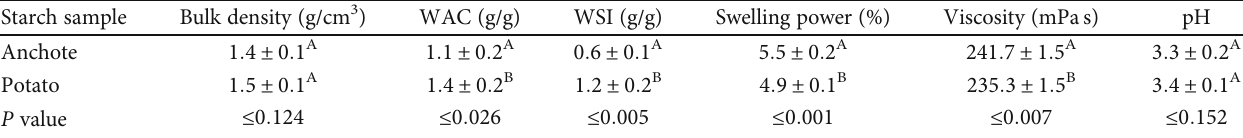
Table 1: Functional and physicochemical properties of potato and anchote starch. Starch sample Bulk density (g/cm 3 )